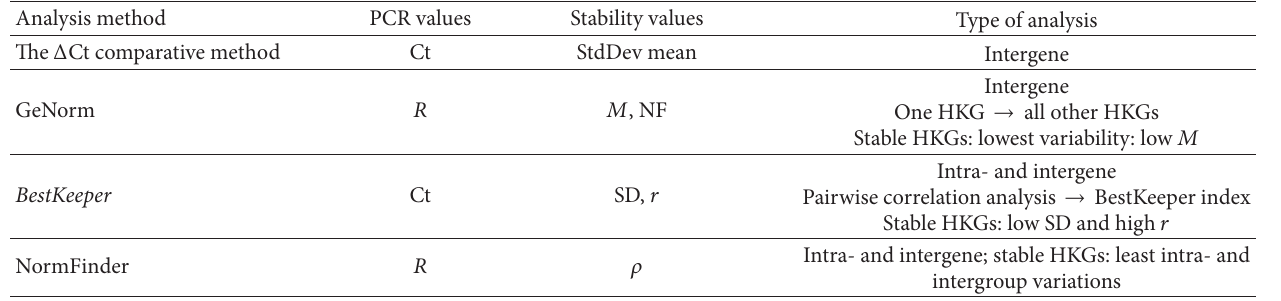
Table 2: The 4 algorithms used in the